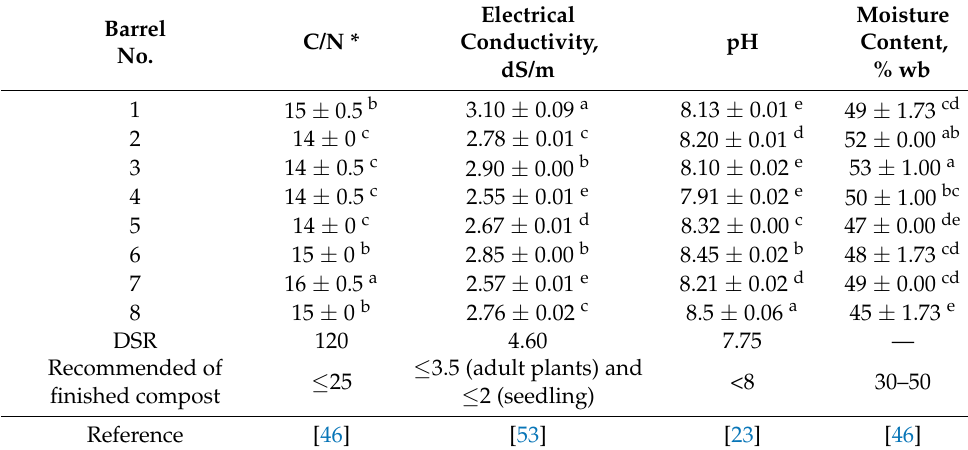
Table 2. Some parameters of DSR and composting mass in each barrel on the 50th day of composting